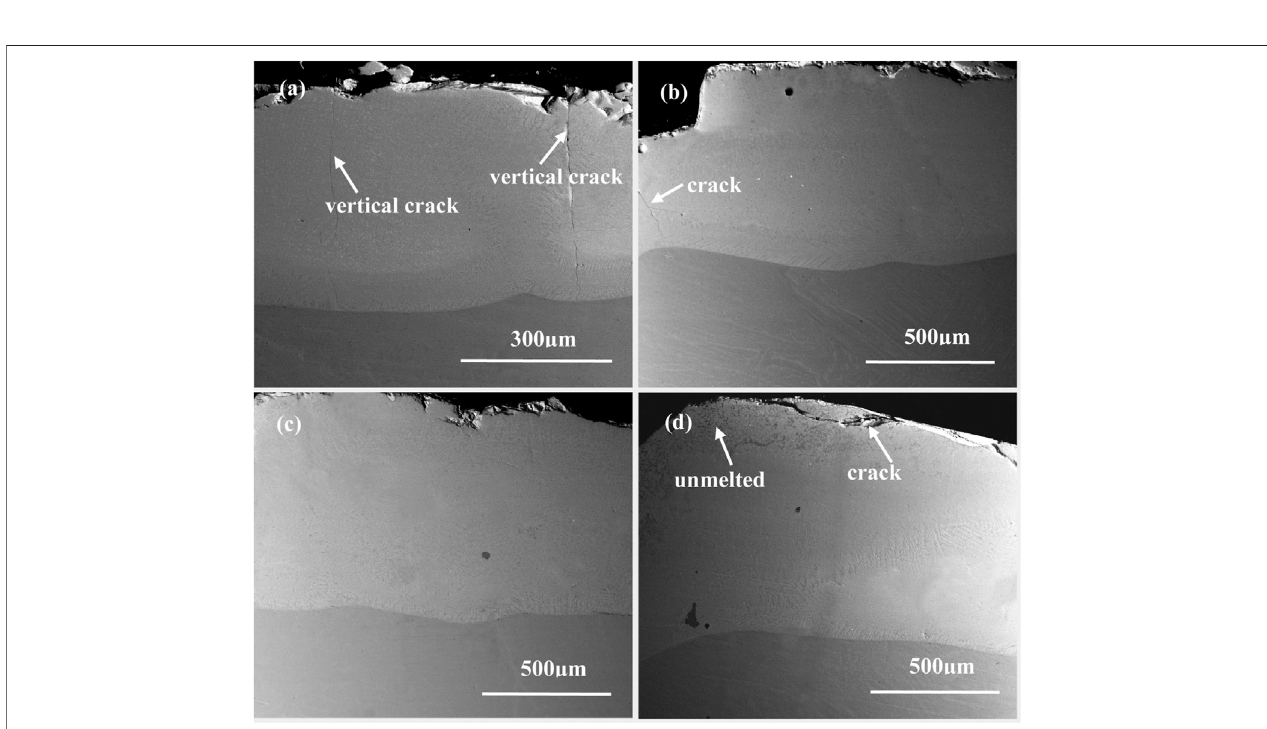
FIGURE 2 | Cross-sectional morphologies of the as-deposited coatings containing (A) 0 wt% Sm 2 O 3 ; (B) 1 wt% Sm 2 O 3 ; (C) 3 wt% Sm 2 O 3 ; (D) 5 wt% Sm 2 O 3 .